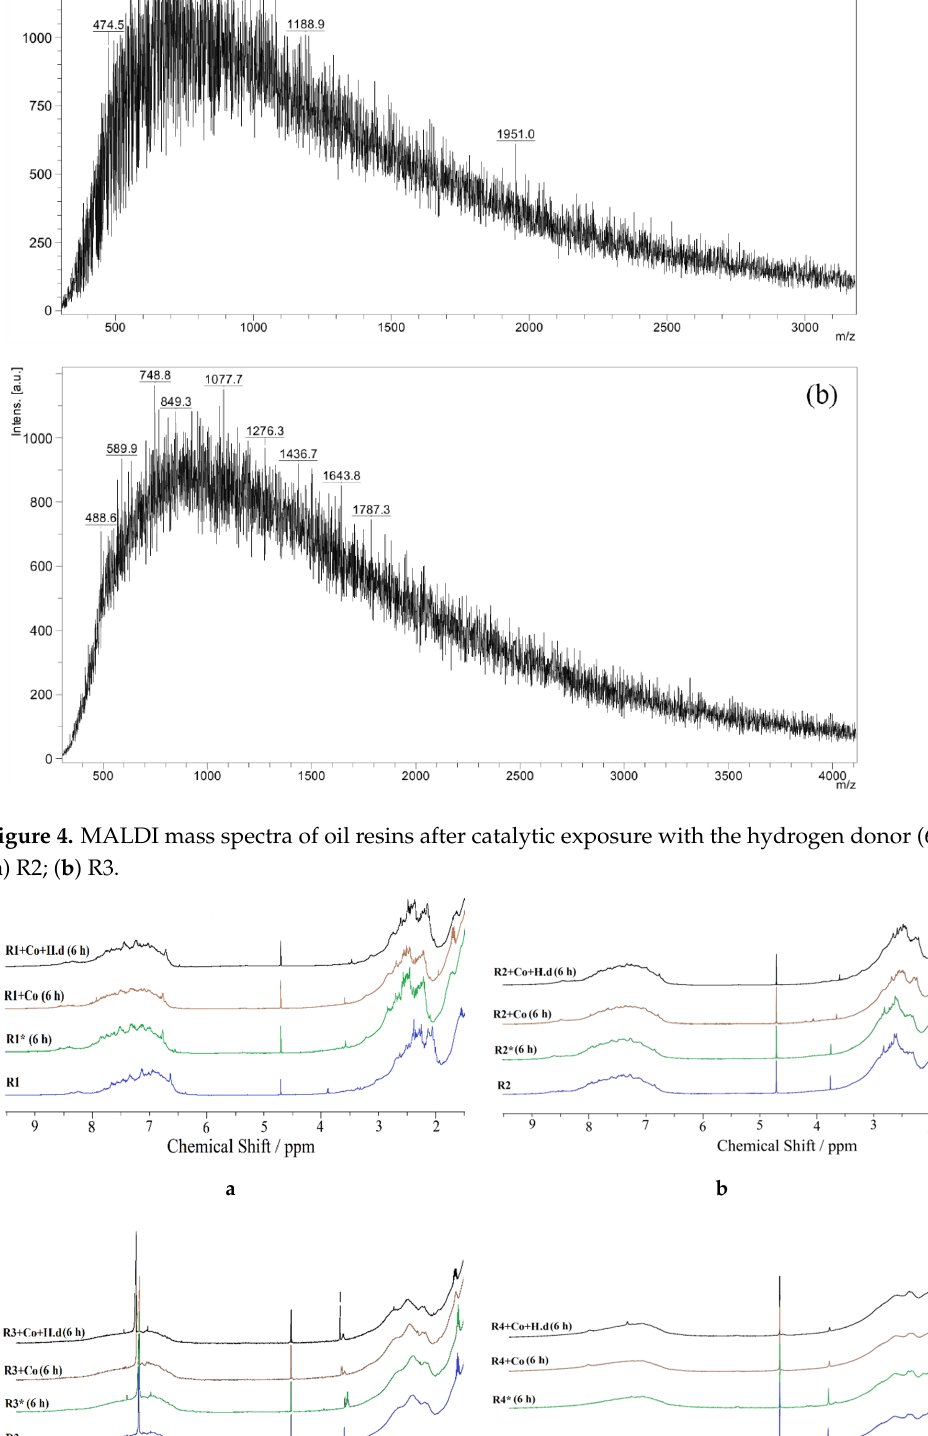
Resins Fraction